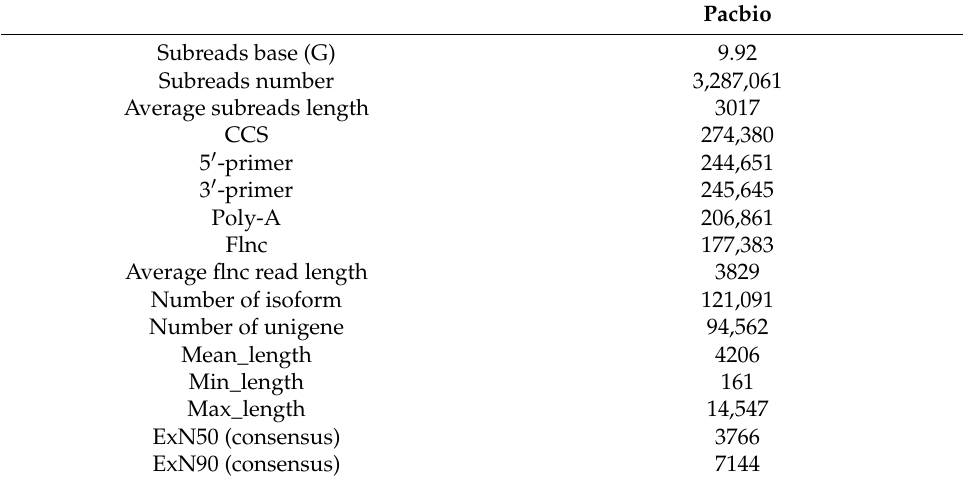
Table 1. Summary for the transcriptome data of H. hamabo using